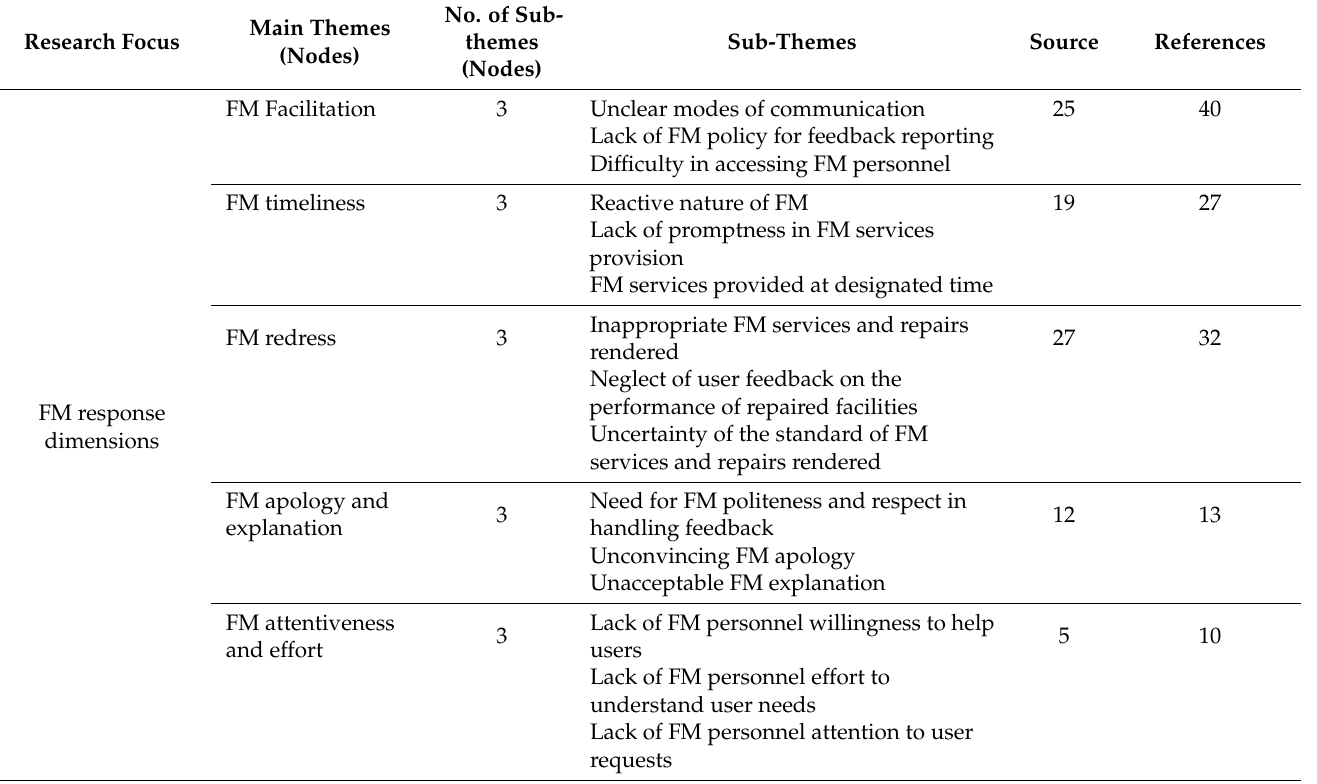
Table 4. Number of nodes and reference found in NVivo